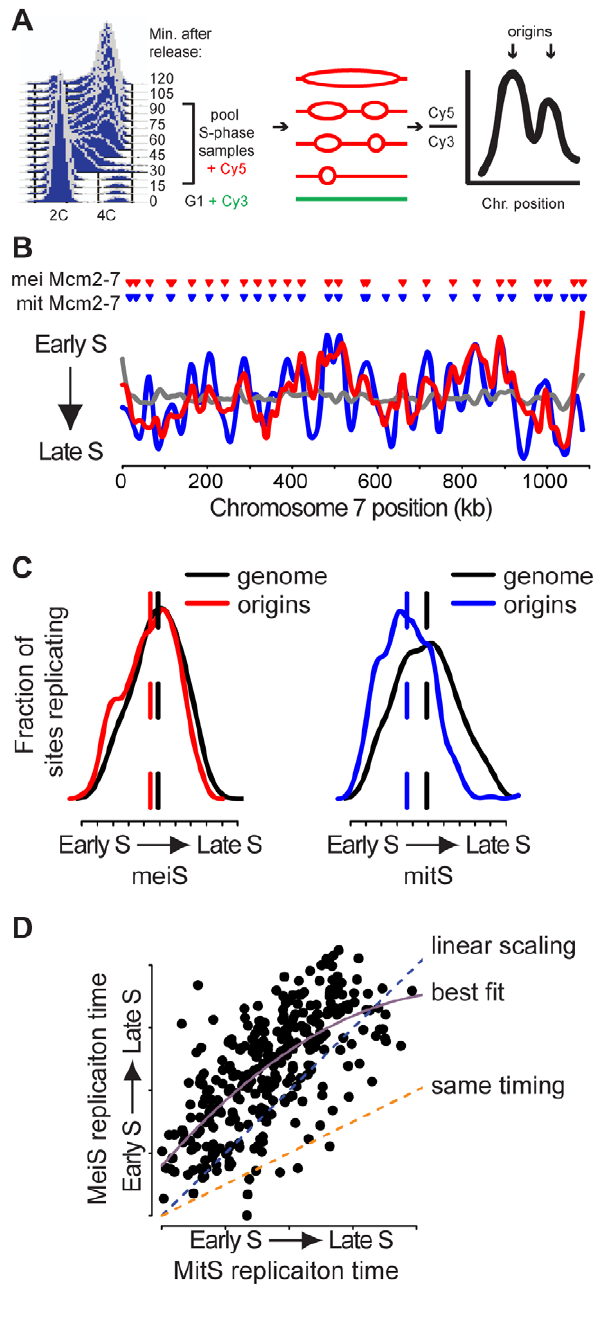
Figure 2. Meiotic DNA replication profiles. (A) Ime2-as1-myc homozygous diploid cells (KBY518) were synchronized in meiS. DNA samples were collected every 7.5 minutes. Resulting samples were pooled and co-hybridized with a G1 DNA sample to a tiled genomic microarray. (B) Replication profiles for meiS (KBY518, red line), mitS (SB1505, blue line) and control G1 vs. G1 (SB1505, grey line) hybridizations were created by plotting the smoothed log 2 ratio (see Materials and Methods) versus chromosome VII position. Triangles indicate the positions of Mcm2-7 binding sites prior to meiosis (red) and mitosis (blue). (C) The distribution of relative replication time for all origins (colored lines) and for the entire genome (black lines) is plotted for meiS (left panel) and mitS phase (right panel). (D) The replication time in meiS of Mcm2-7 binding sites that were present in both cell cycles were plotted as a function of mitS replication time. Assuming meiS is twice as long as mitS, the orange dashed line indicates the predicted meiS replication time if origins replicated with the